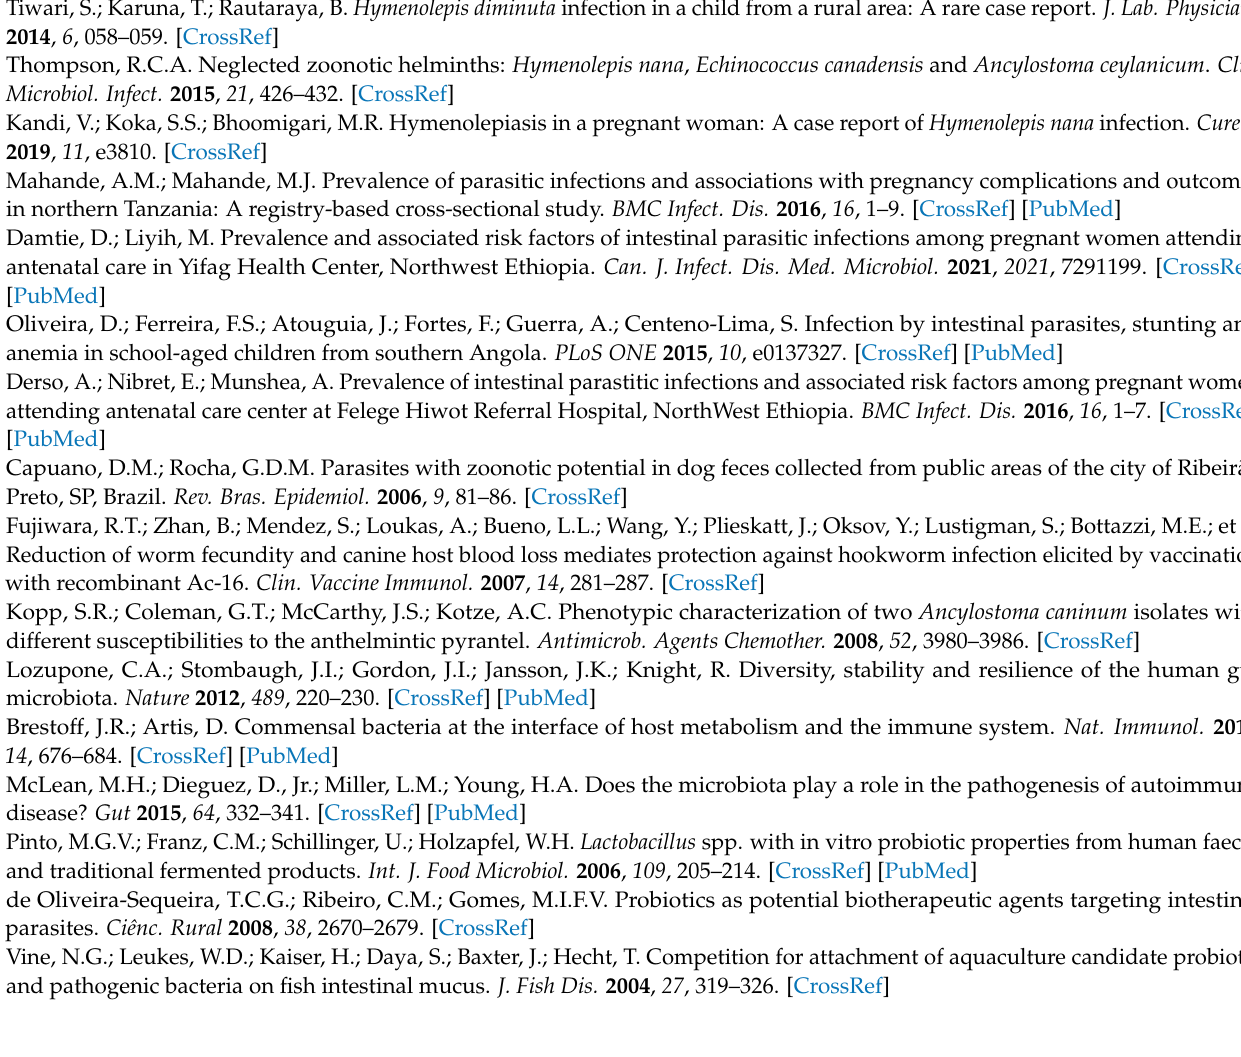
for the strain S10; Table S2: Database showing matching for the strain S13; Table S3: Database showing matching for the strain S14; Table S4: Database showing matching for the strain S17; Table S5: Database showing matching for the strain S27; Table S6: Database showing matching for the strain S29; Figure S1: Detection of outlier in the LAB